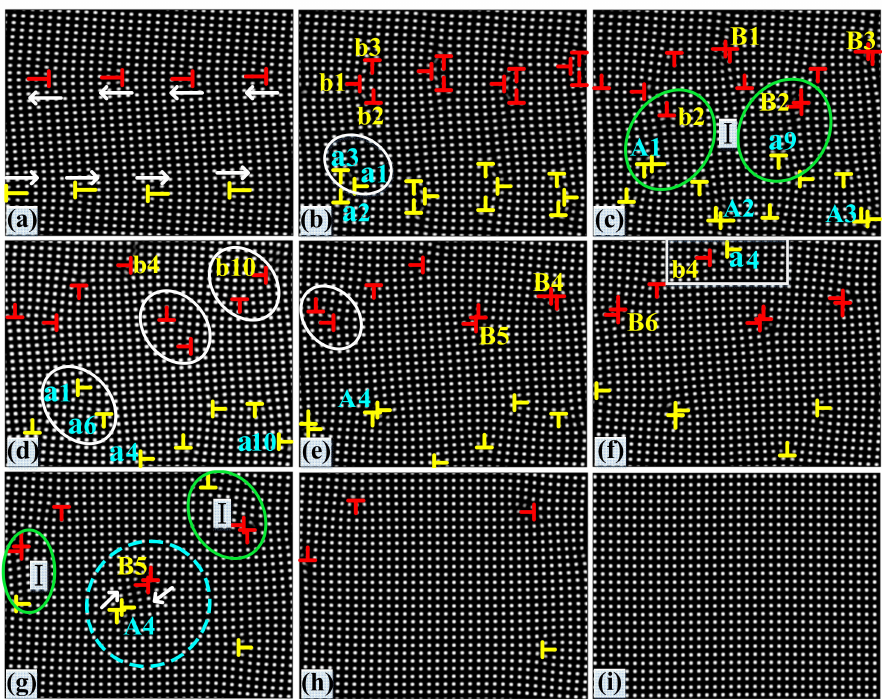
Figure 3. The evolution of dislocations in sample A. The white arrow indicates the migration direction. Type I semi-annihilation occurs in the green solid line area. The full annihilation of dislocation pairs occurs in the blue dotted line area. New dislocation pairs are about to form in the white solid line area. The ( a – i ) corresponding time steps are t * = 15,000; t * = 24,100; t * = 24,700; t * = 25,100; t * = 25,800; t * = 27,100; t * = 28,800; t * = 29,900; and t * =